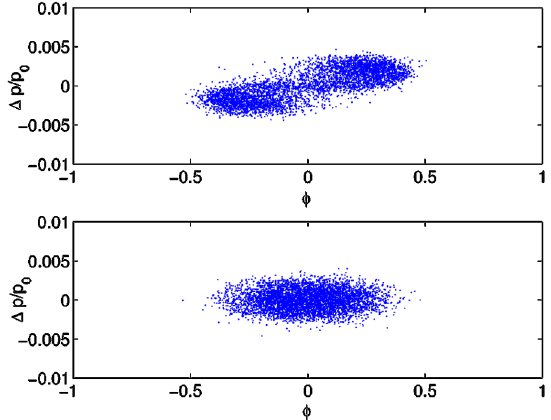
FIG. 4. (Color) Top panel: the phase-space distribution of a beam with voltage modulation at f 49 : 663 kHz , (cid:7) (cid:3) 0 : 026 . Bottom panel: the phase-space distri- bution of electron beams without rf voltage